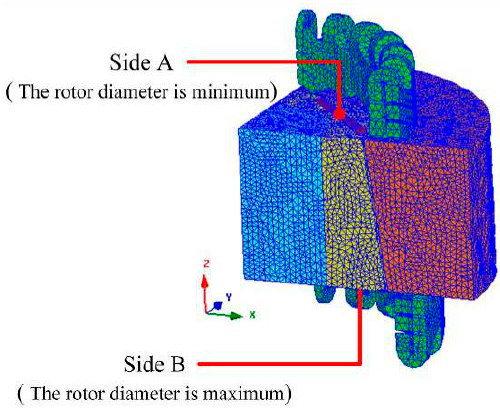
Figure 5. 3-D finite-element (3-D FE) model of CR-PMSM.